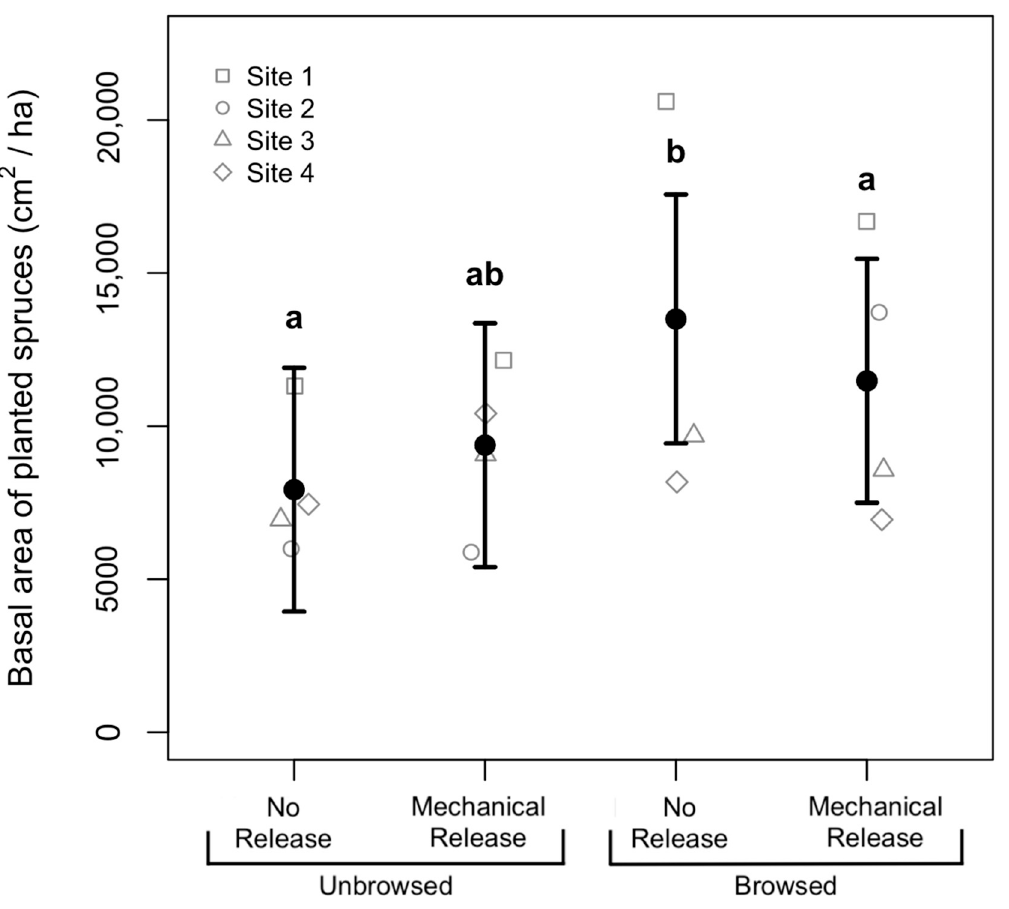
Figure 4. Basal area of the planted white spruces in four plantations receiving combinations of browsing exclusion (unbrowsed or browsed) and forest cleaning (no release or mechanical release) treatments. Predicted values were estimated from a linear mixed effects model with the forest cleaning treatment nested within the browsing exclusion treatment, nested within the site, as a random factor. Error bars are 95% confidence intervals. Raw averages are shown in gray. Treatments that do not share at least one similar letter are significantly different at p = 0.1.